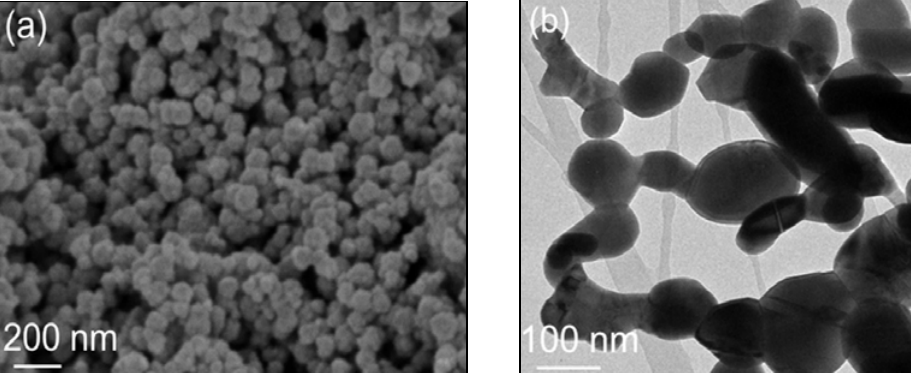
Figure 5. SEM (a) and TEM (b) images of the self-prepared ZnFe